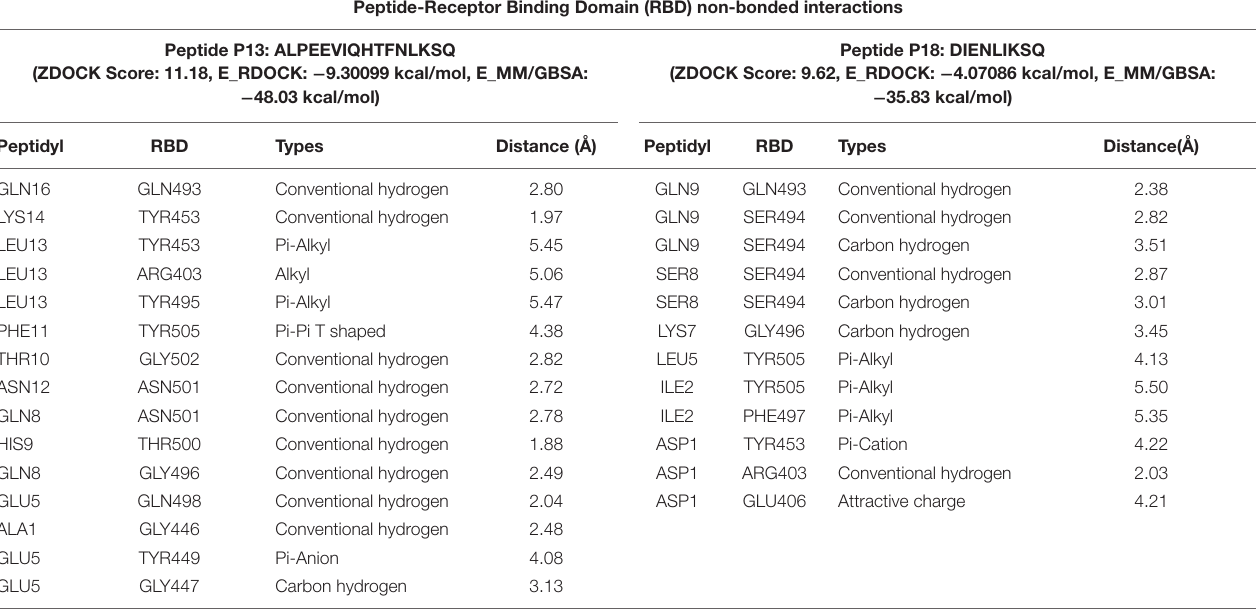
TABLE 2 | Details of non-bonded interactions between the peptides and SARS-CoV-2 receptor binding domain. Peptide-Receptor Binding Domain (RBD) non-bonded interactions Peptide P13: ALPEEVIQHTFNLKSQ (ZDOCK Score: 11.18, E_RDOCK: − 9.30099 kcal/mol,